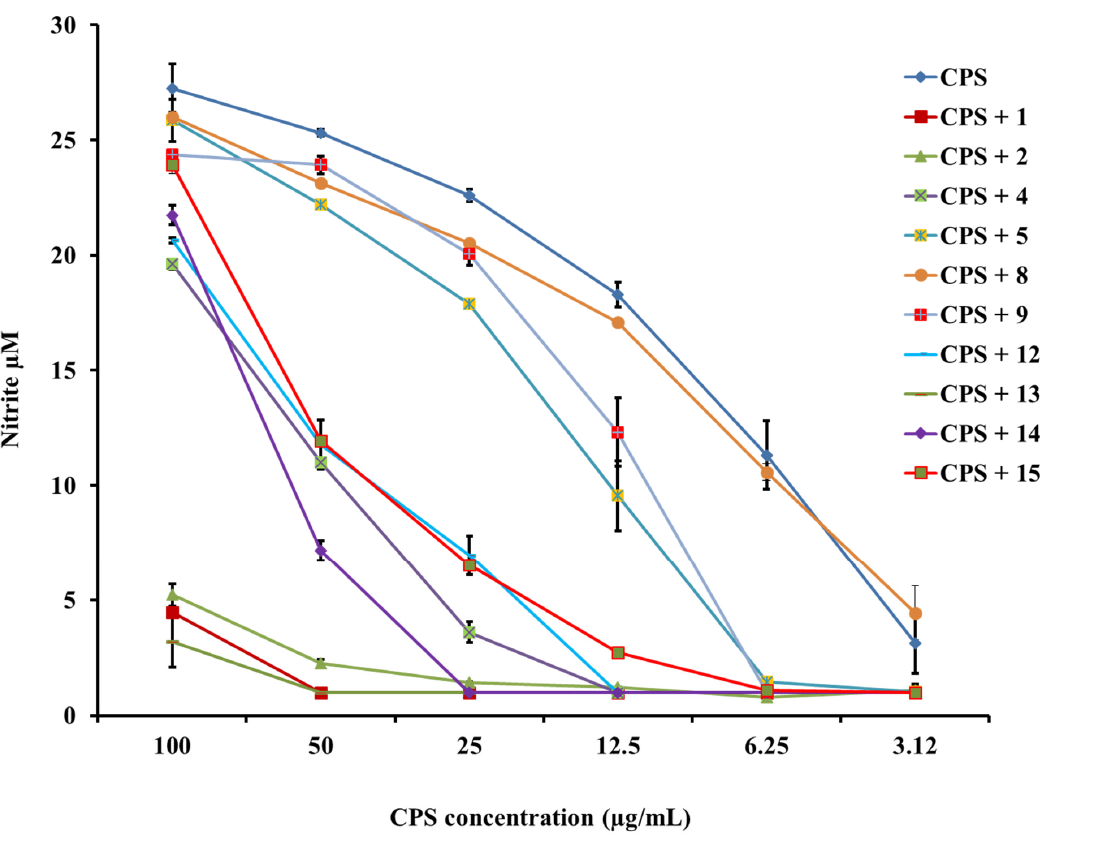
Figure 7. PG-1 analogs neutralized meningococcal capsular polysaccharide (CPS) polymer activity and inhibited nitric oxide release. CPS polymers were purified from the endotoxin-deficient serogroup B meningococcal NMB- lpxA mutant designated CPS. Nitric oxide was released from murine RAW264 macrophages induced overnight with doses of meningococcal CPS polymers pre-incubated with or without 2 µg/mL of PG-1 or its analogs for 30 min at 37 °C. Nitric oxide release was measured by the Greiss method. Error bars represent ±SD from the mean of duplicate measurements. This experiment is representative of two independent